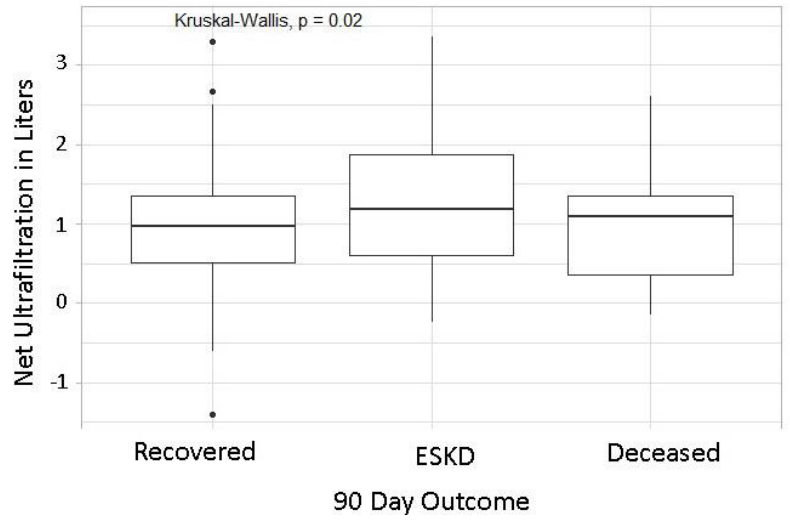
Figure 2. Analysis of Net Ultrafiltration across all sessions. ESKD: End Stage Kidney disease.